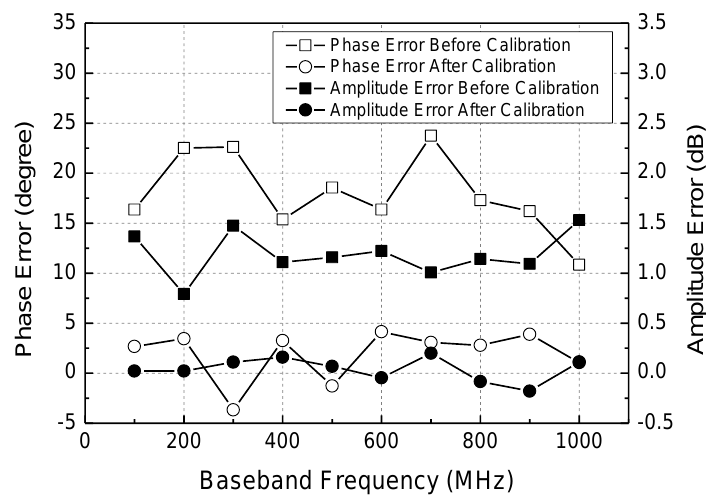
Figure 14. Measured I/Q amplitude and phase mismatches before and after calibration.